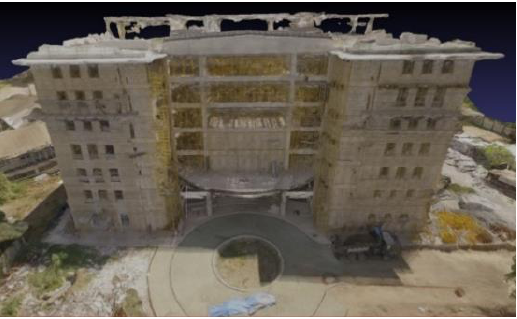
Figure 7. Generated raw mesh for March 5,2017 flight observation